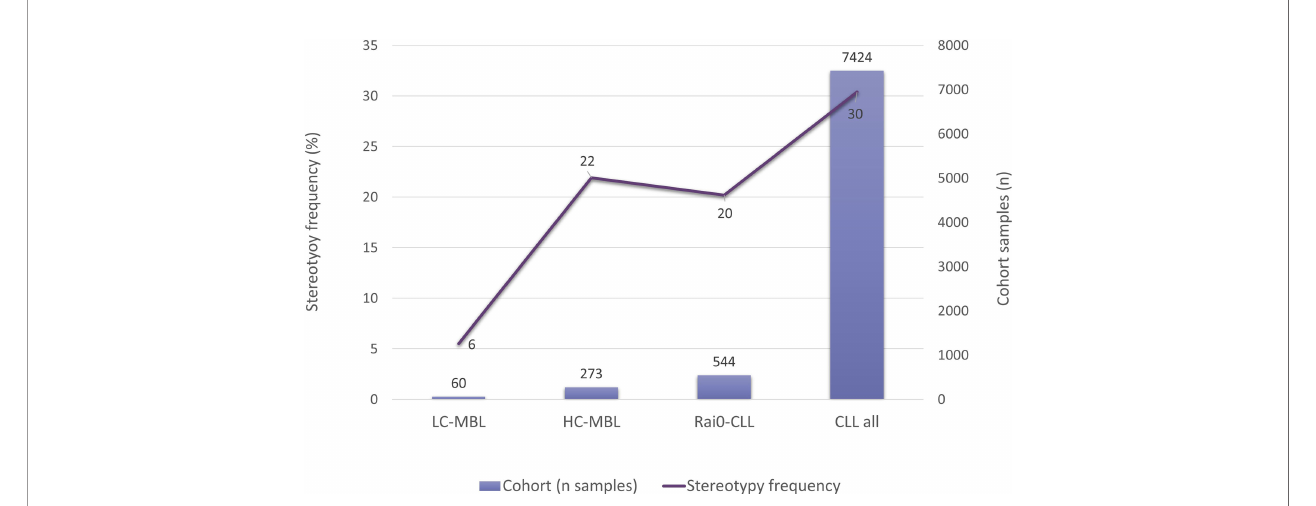
FIGURE 6 | Frequency of BcR IG stereotypy in LC-MBL, HC-MBL, Rai 0 CLL and CLL from all clinical stages. Data was extracted from Vardi et al.